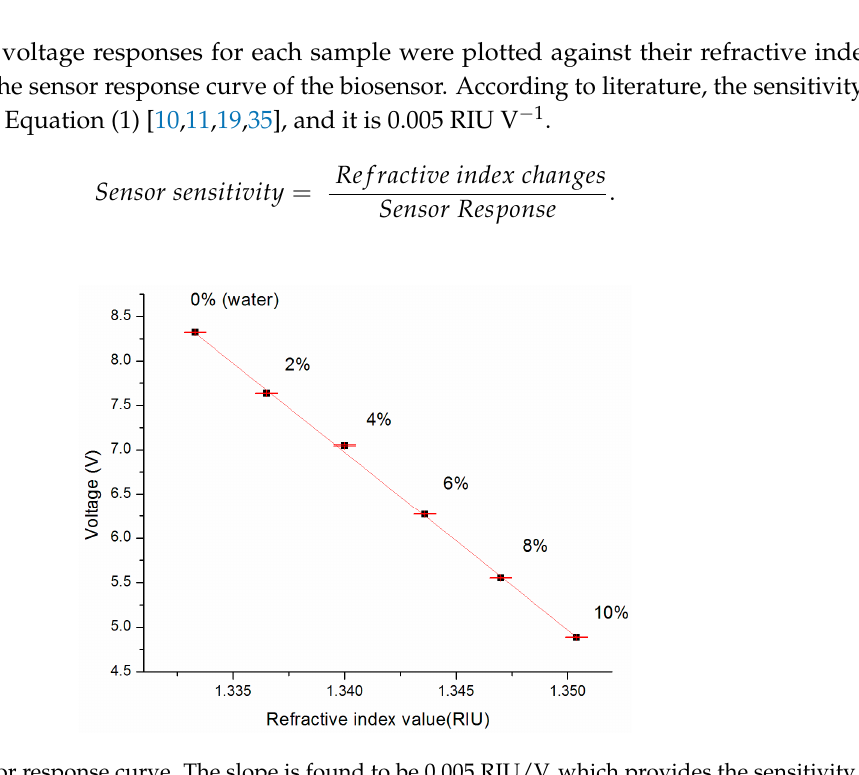
Figure 4. Sensor response curve. The slope is found to be 0.005 RIU/V, which provides the sensitivity of the sensor.